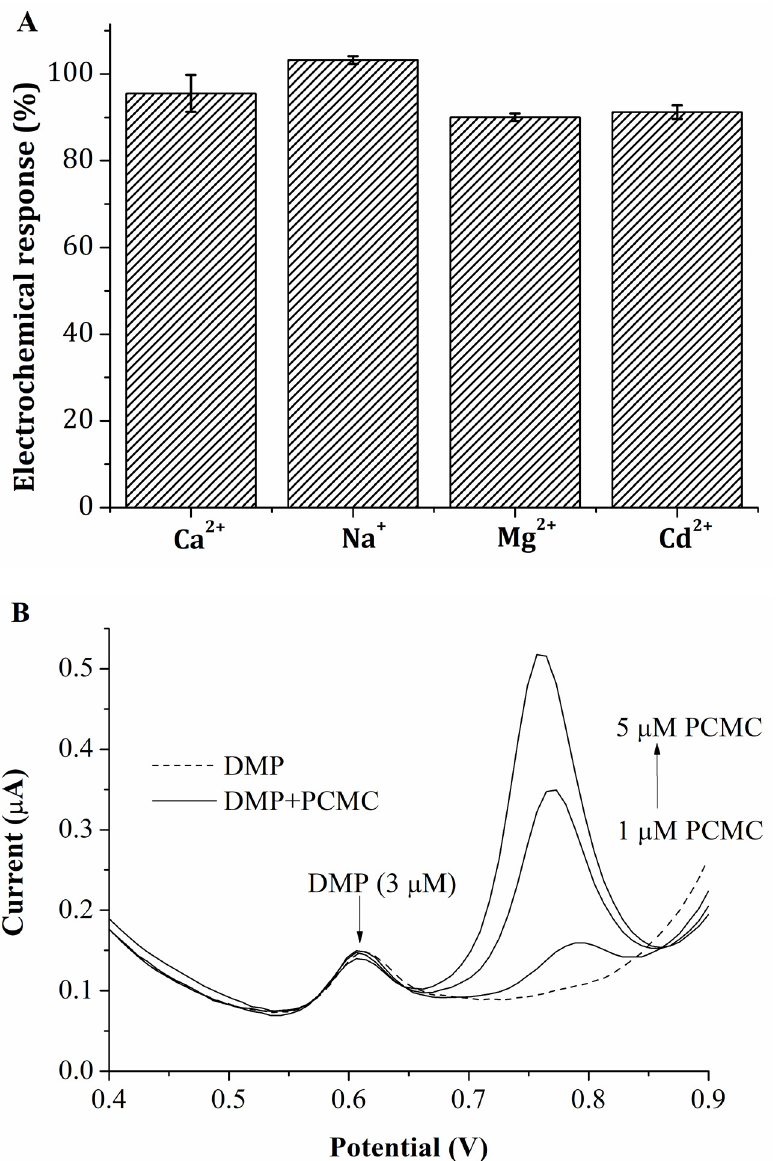
Figure 6. ( A ) Electrochemical responses obtained with SNG–C–2% PANI in presence of 7 µ M of 4-chloro-3-methylphenol and 700 µ M of calcium and sodium salts and 70 µ M of magnesium and cadmium salts. ( B ) Differential Pulse voltammograms recorded with the developed material in presence of different concentrations of PCMC and 3 µ M of DMP. A buffer solution containing 0.1 M acetic/acetate at pH 4 with 0.5 M KCl was used as electrolytic medium.